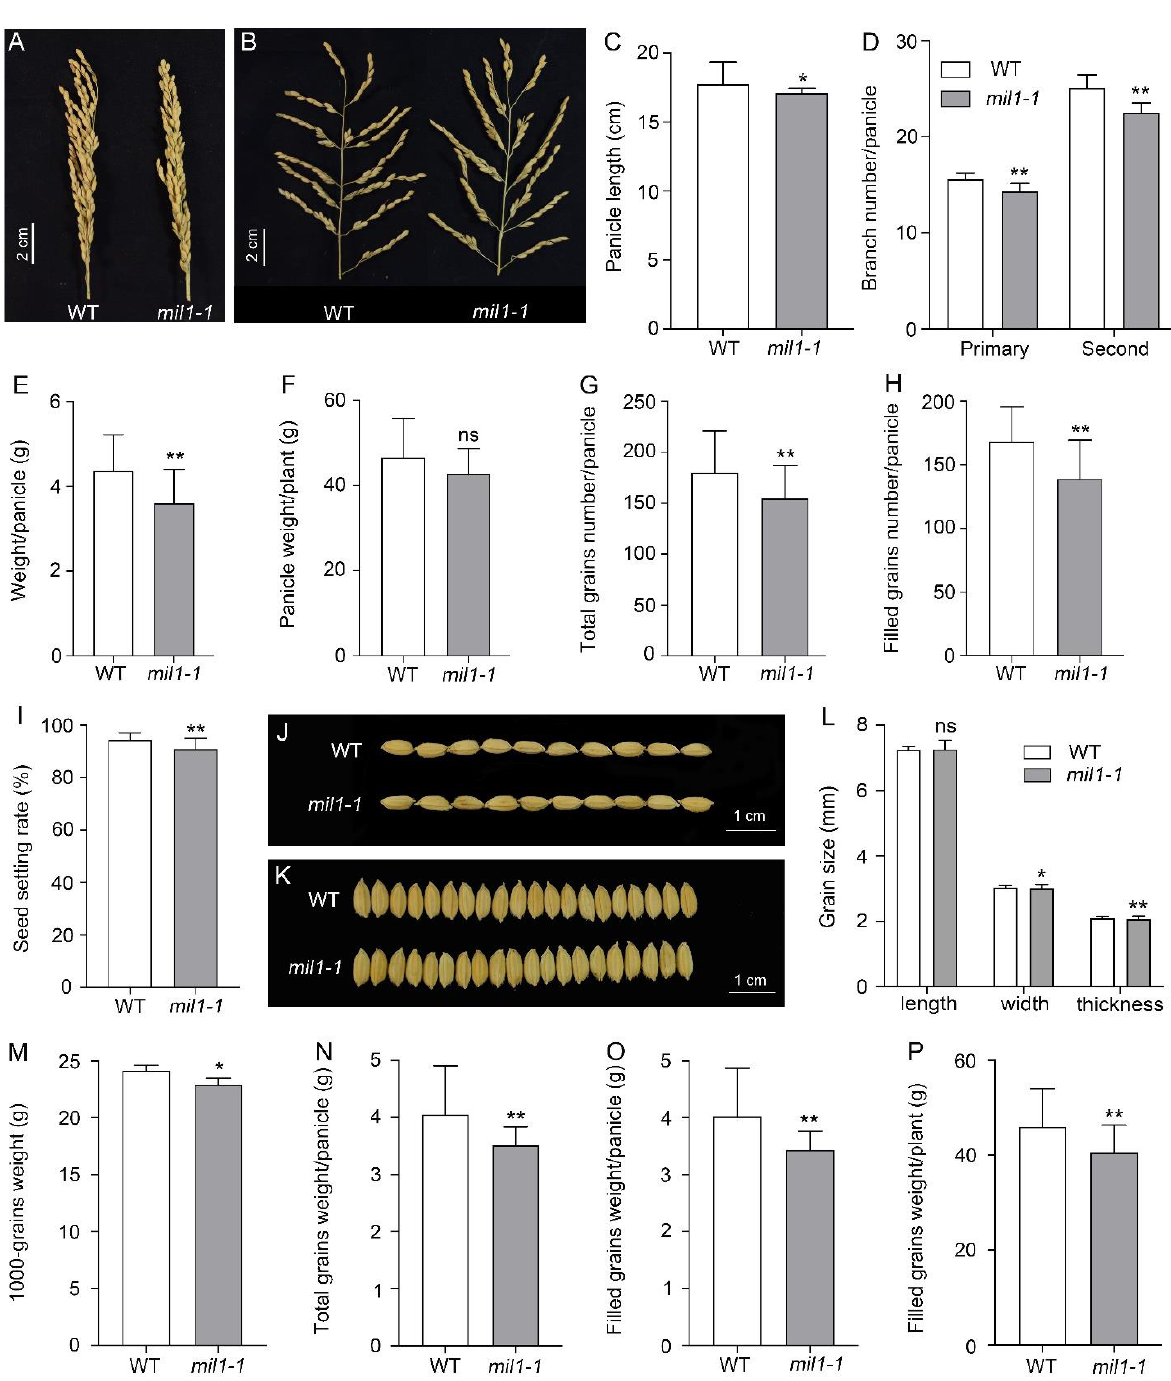
Figure 4. Agronomic traits related to yield formation in WT and mil1-1 . ( A – F ) Panicle traits, including panicle length ( A – C ), branch number/panicle ( D ), weight/panicle ( E ), and panicle weight/plant ( F ) in WT and mil1-1 ; ( G – O ) Grain features, such as total grains number/panicle ( G ), filled grains number/panicle ( H ), seed setting rate ( I ), grain size ( J – L ), 1000-grains-weight ( M ), total grains weight/panicle ( N ), and filled grain weight/panicle ( O ). ( P ) Filled grain weight/plant. Data in ( C – I) and ( L – P) are means ± SD. A two-tailed unpaired t - test with Welch’s correction is used for statistical analysis. Asterisks indicate significant differences between treatments and respective controls at each time point (* p < 0.05, ** p < 0.01; Student’s t test).